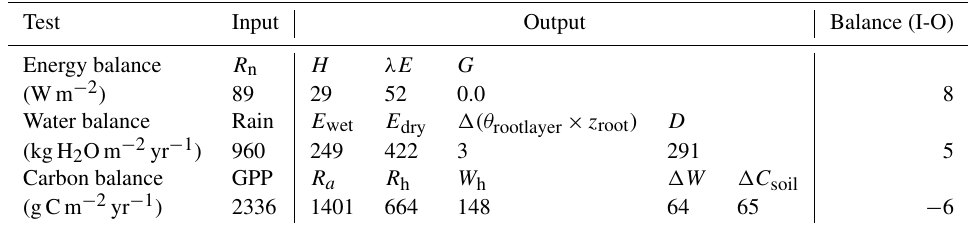
Table 2. Verification tests operated on the model. The test is a simple conservation test applied to the annual values of energy, water and carbon fluxes over the 1984 to 2010